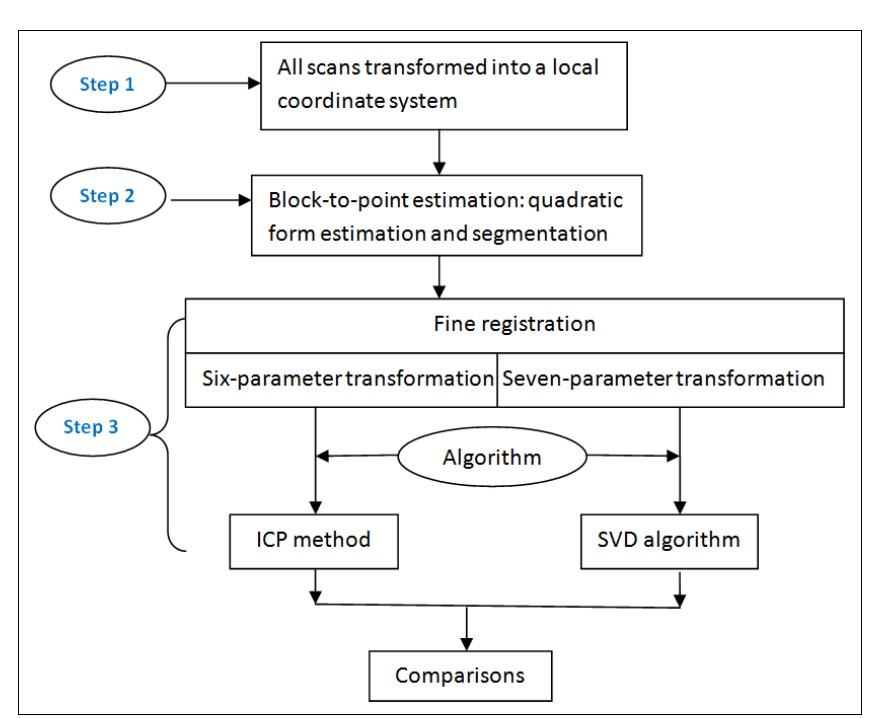
Figure 1. Data processing workflow of Terrestrial Laser Scanning (TLS) applied in structural monitoring tasks. ICP, Iterative Closest Point; SVD, Singular Value